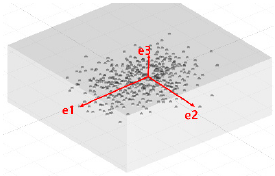
Figure 5. Principal component analysis (PCA) eigenvector.